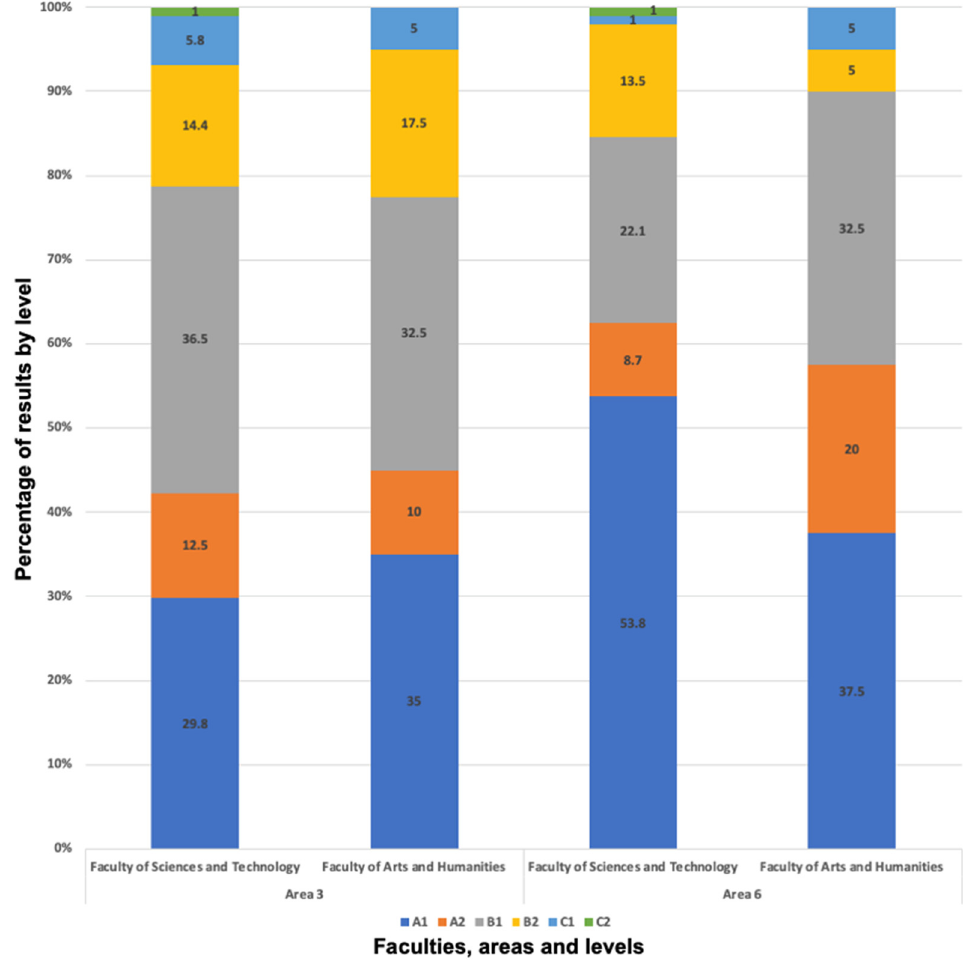
Figure 10. Comparison of results from Areas 3 and 6 at the Faculties of Science and Technology and Arts and Humanities.